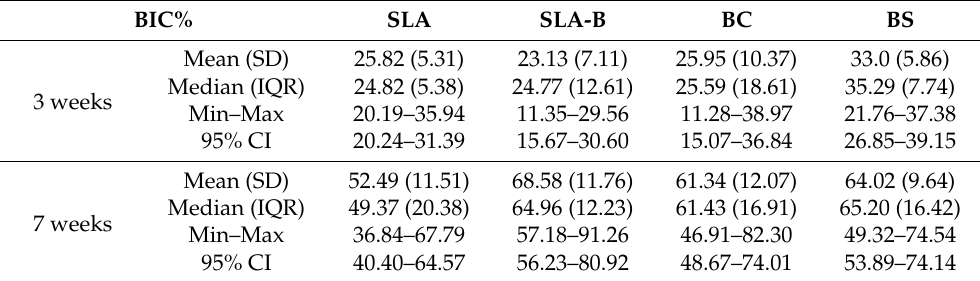
Table 5. Bone–implant contact percentages (BIC%) in the early and late-healing periods .